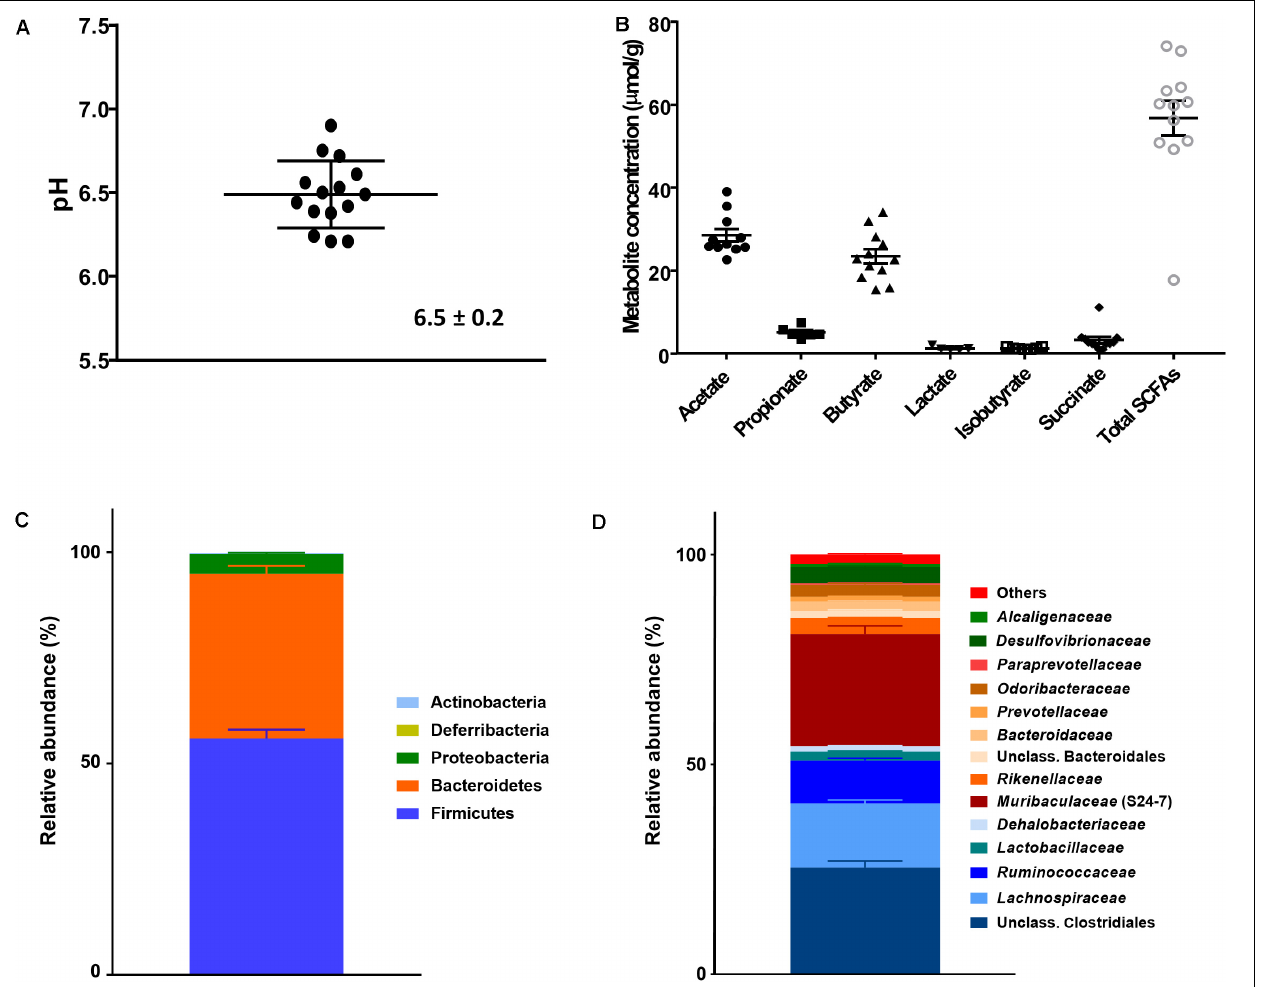
FIGURE 1 | Analysis of caecal contents of WT C57BL/6 mice (means ± SEM; n = 15). (A) pH; (B) Metabolite concentrations ( µ mol/g); (C) Microbial composition obtained by 16S rRNA amplicon sequencing and expressed as relative abundance at phylum and (D) family level. Data are mean ± SEM. Values < 1% are summarized in the group